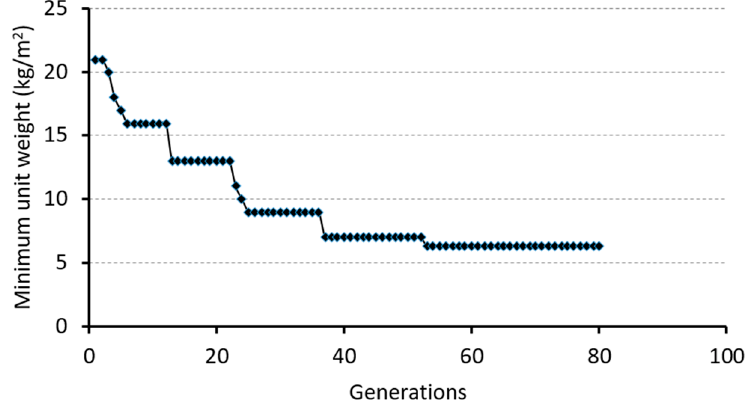
Figure 10. Convergence history of design optimization for frame having semi-rigidity at apex joint.